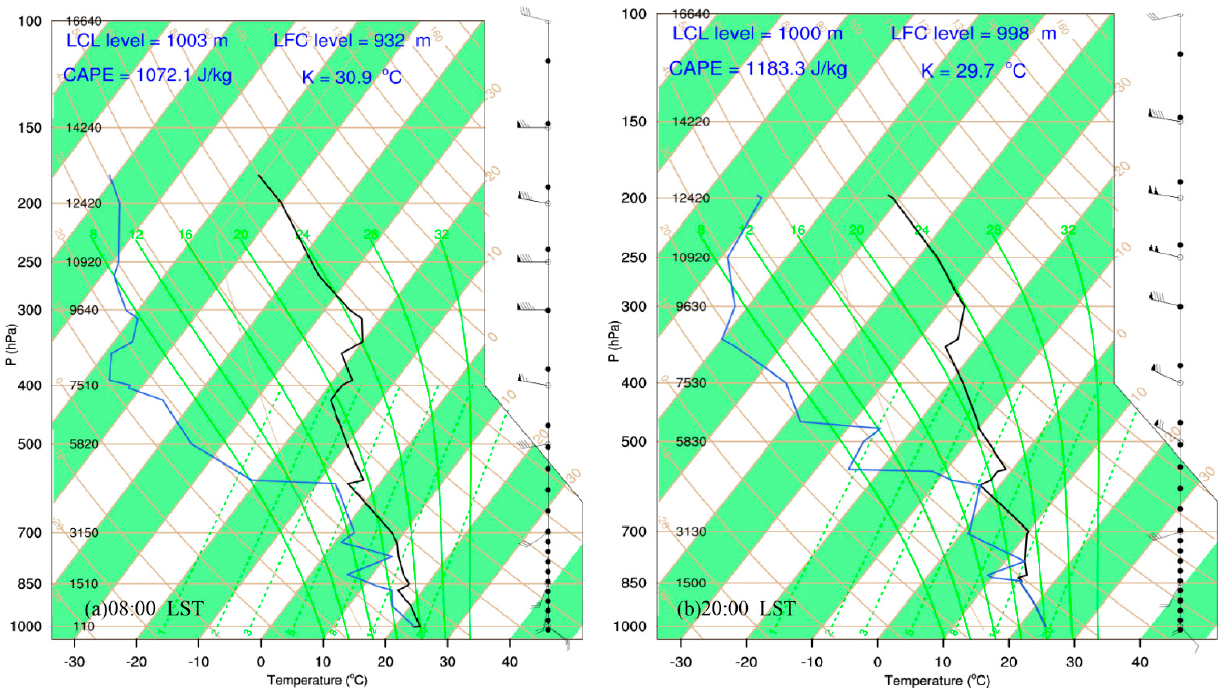
Figure 3. Skew T − logP diagrams at the Yangjiang station (59663) at ( a ) 08 LST and ( b ) 20 LST on 27 March 2020. The values of CAPE, LCL, and LFC were calculated for the near-surface (0 to 500 m) air after the adjustment and are labeled on the top of each panel. A full wind barb is 4 m·s − 1 , and a flag represents 20 m·s − 1 .